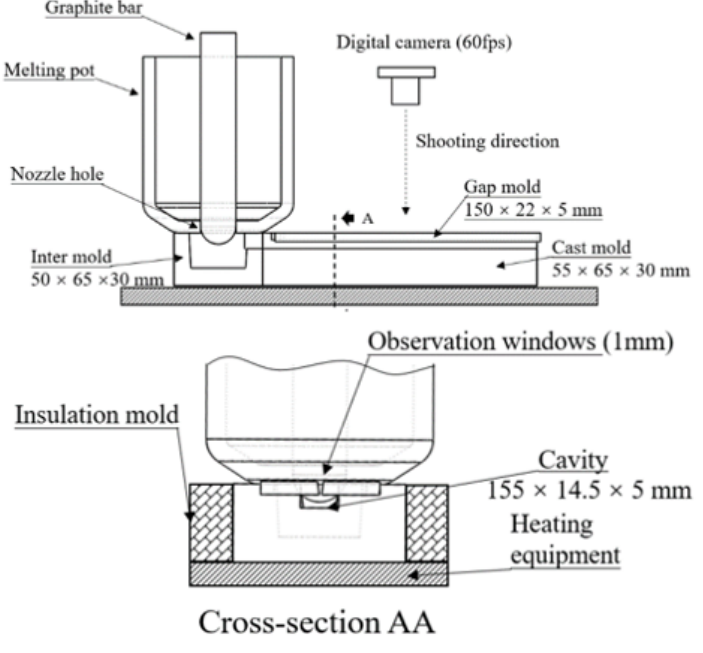
Figure 2. Schematic diagram of experimental device (front and section